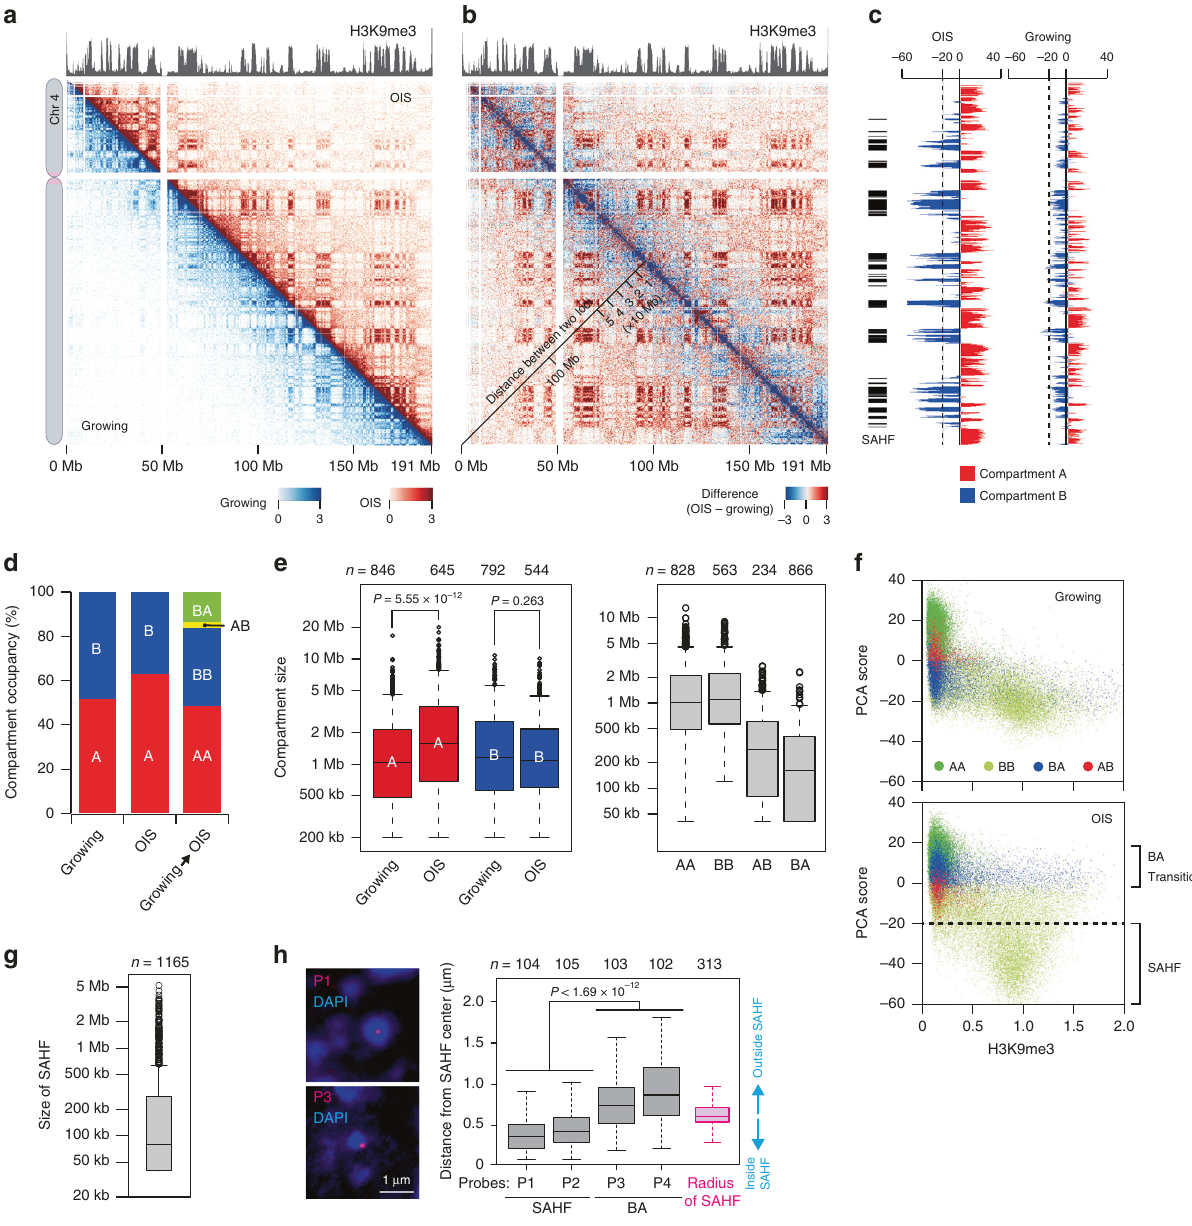
Fig. 2 Compartmental reorganization and SAHF formation upon OIS. a Contact maps for chromosome 4 in OIS (top right) and growing cells (bottom left) at 200 kb resolution. Contact maps were plotted as detailed in Supplementary Fig. 3. b Difference of contact probabilities between OIS and growing cells. Red and blue dots indicate that contact probabilities are higher in OIS and growing cells, respectively. c PCA (principal component analysis) scores in OIS and growing cells plotted along chromosome 4. PCA scores were calculated as described in Methods. SAHF were de fi ned as genomic regions with PCA scores < − 20; locations are indicated by black bars at left. d Occupancy of A and B compartments in growing and OIS cells (for replicate #1). Rightmost column shows compartmental switching (AB or BA) or not (AA and BB) between growing and OIS cells. Details are in Supplementary Fig. 4b. e Left: Size distributions of A and B compartments in growing and OIS cells (for the same data as in panel d ; two-sided Mann – Whitney U test) shown as boxplots (central bar represents the median with boxes indicating the upper and lower quartiles, and whiskers extend to the data points, which are no more than 1.5× the interquartile range from the box; outliers shown as circles). Numbers of A and B compartments are shown at top. Right: Size distributions and numbers of genomic regions that belong to the respective compartmental categories. f Correlation between PCA score, H3K9me3 enrichment and chromatin compartment. PCA scores of every 40 kb bin across the human genome were plotted against histone H3K9me3 enrichment score in growing and OIS cells (for replicate #1). Dot colors represent genomic regions that belong to the indicated compartmental categories. g Size distribution of the SAHF de fi ned in panel f . h FISH visualization of the SAHF-forming heterochromatic (P1 and P2 probes) and BA-switching loci (P3 and P4 probes) in OIS cells (Methods). Probe positions are shown in Supplementary Fig. 4h. Left: Examples of FISH images for the P1 and P3 probes. SAHF were visualized by DAPI staining. Right: The distance between a center of DAPI-dense area and FISH signal was measured in the indicated numbers of cells (top). Distance distributions shown as boxplots (central bar represents the median with boxes indicating the upper and lower quartiles, and whiskers extend to the data points, which are no more than 1.5× the interquartile range from the box) were compared between the SAHF and BA-switching loci (two-sided Mann – Whitney U test). DAPI signals were used to measure radiuses of SAHF.